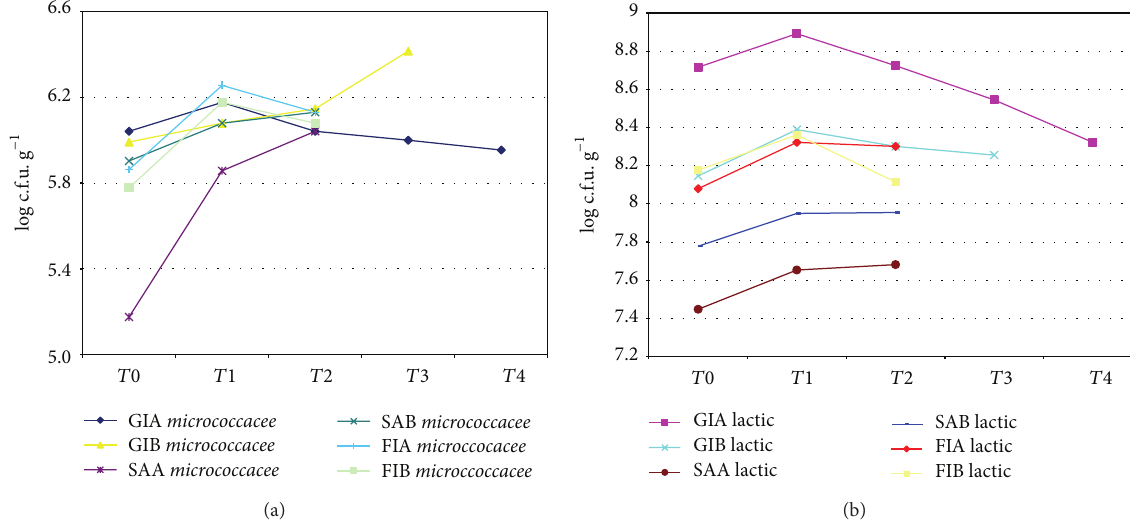
Figure 2: (a) Evolution of Micrococcaceae bacteria during ripening of Giarolo , Tipico Tortonese , and Filetto Baciato salami (log c.f.u. g −1 ). (b) Evolution of lactic acid bacteria during ripening of Giarolo , Tipico Tortonese , and Filetto Baciato salami (log c.f.u. g −1 ).